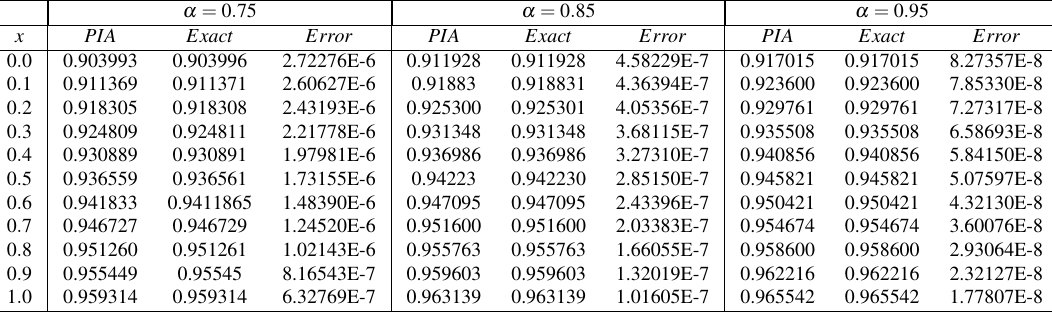
Fig. 6 The surface plot of the PIA solution v 4 ( x , y , t ) for ℜ = 100 and t = 0 . 1 when α = 0 . 95 . Table 1 PIA ( u 4 ( x , y , t ) ) and exact solution values with absolute errors for y = 1 , t = 0 . 1 and ℜ = 100 . α = 0 . 75